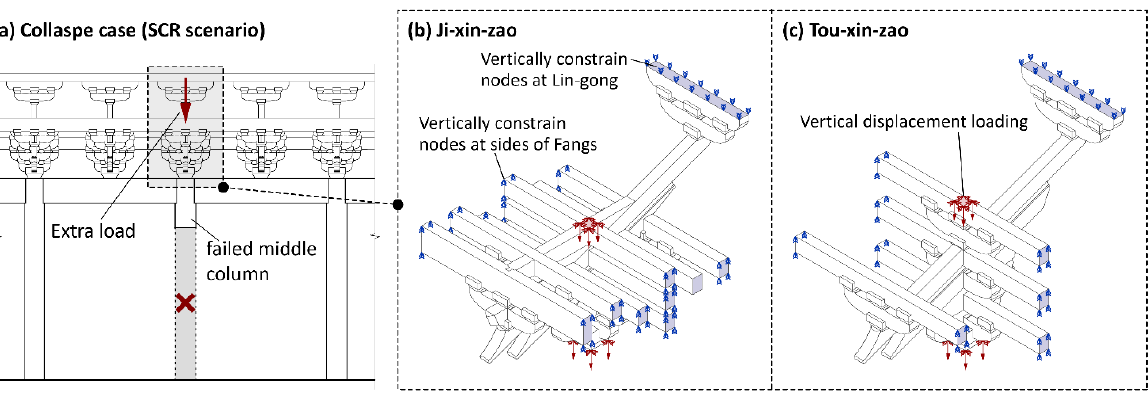
Figure 6. Load and boundary definitions of the two finite element models corresponding to the roof load condition. ( a ) Roof load case; ( b ) Ji-xin-zao; ( c ) Tou-xin-zao.